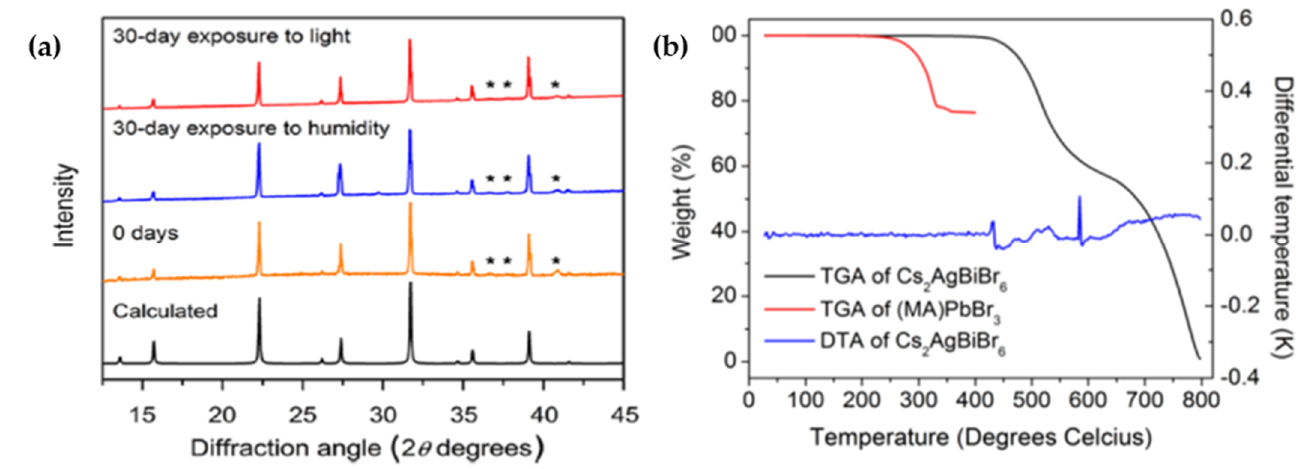
Figure 4. ( a ) PXRD pattern of Cs 2 AgBiBr 6 after exposure to humidity (55% RH) and light (0.75 Sun), * and ** refers to the signals from sample holder; ( b ) Thermogravimetric analyses of Cs 2 AgBiBr 6 and (MA)PbBr 3 at a scan rate of 5 ◦ C/min and 1 ◦ C/min, respectively. Solid (MA)PbBr 3 shows an initial mass loss at 176 ◦ C. Solid Cs 2 AgBiBr 6 shows an initial mass loss at 430 ◦ C. DTA of Cs 2 AgBiBr 6 shows no phase changes until the mass loss onset. Reproduced with permission from [48]. Copyright 2016, American Chemical Society.